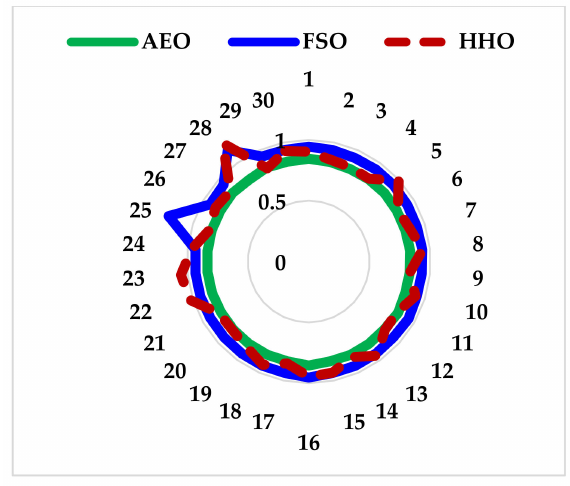
Figure 9. Fitness for cost of energy without DSM at 80% REF and 0% LPSP.